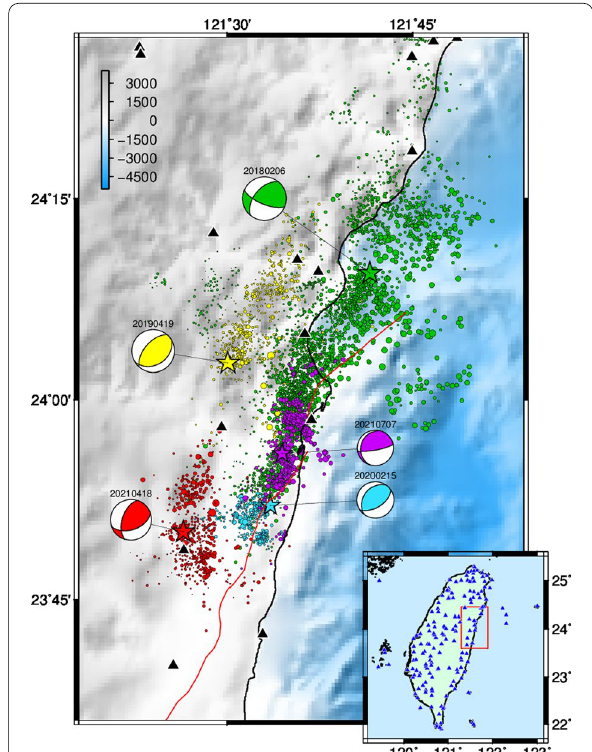
Fig. 2 Earthquake distribution of the 2018–2021 earthquake clusters near Hualien city. Colored dots represent earthquakes in different clusters, with mainshock events denoted by the star. Red lines represent the Longitudinal Valley Fault in the south and the Milun Fault in the north. Blue triangles in the lower‑right inserted map shows the seismic station used in this